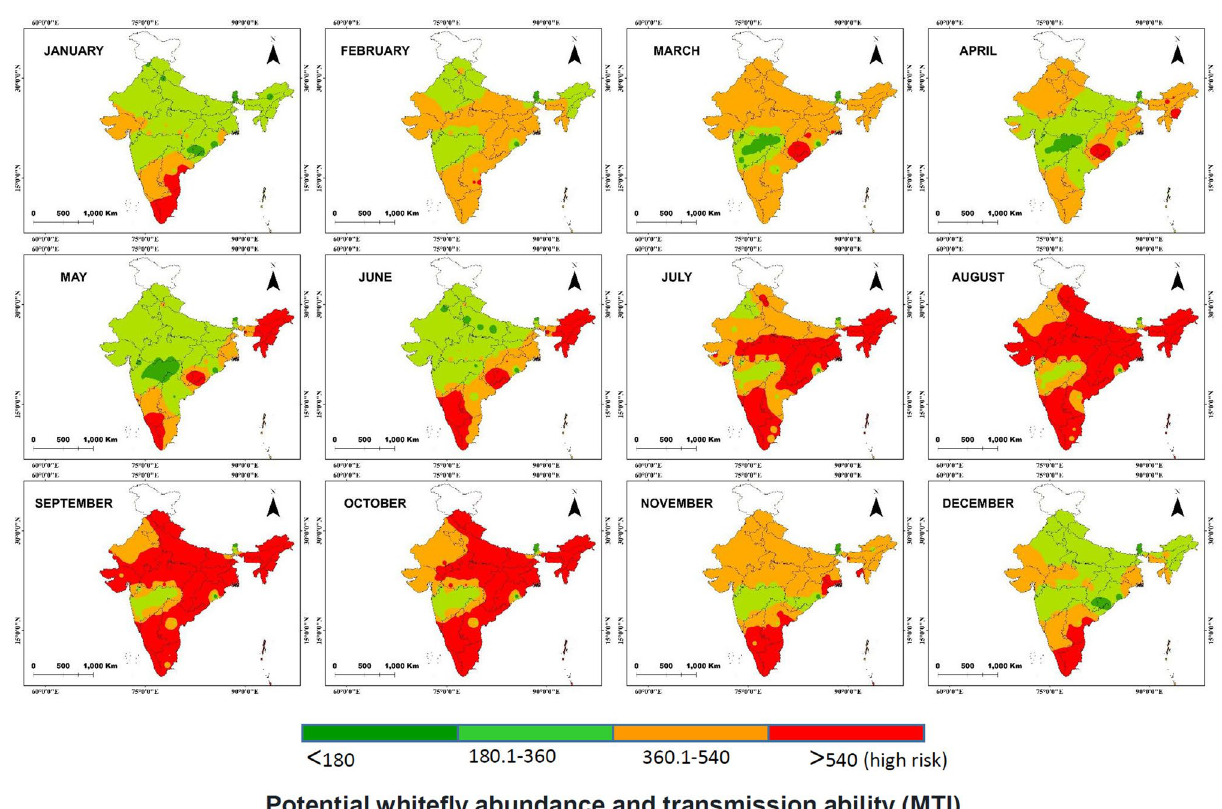
Figure 6. Prediction of spatio-temporal distribution of whitefly abundance (measured as growth and development index) in relation to monthly temperature index based on the prevalent temperature data (2001– 2018) across the major chili growing areas in India; spatial interpolation (IDW in ArcGis 10.0 http://www.arcgi s.com); red and dark green colors indicate high and low risk, respectively for whitefly population as well as leaf curl disease in